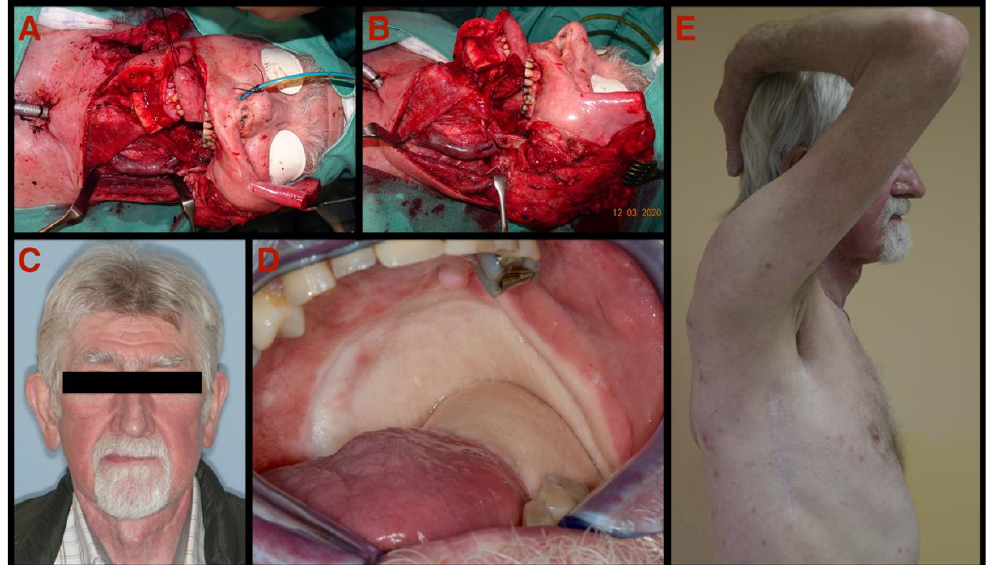
Figure 3. Seventy-four-year-old male patient with squamous cell carcinoma of the oral cavity: ( A , B ) intraoperative view after ablation of the squamous cell carcinoma of the oral cavity and modified radical neck dissection; ( C ) postoperative frontal view 8 months after reconstruction with the TDAP-Scap-aa flap; ( D ) intraoral postoperative clinical view depicting the totally integrated transplant involving the mandible, the tongue and the pharyngeal wall 8 months after reconstruction with this microvascular free flap (TDAP-Scap-aa free flap); ( E ) donor site 14 months after surgery. Full range of shoulder movement without restrictions. Note: Pictures are taken from case number 19.